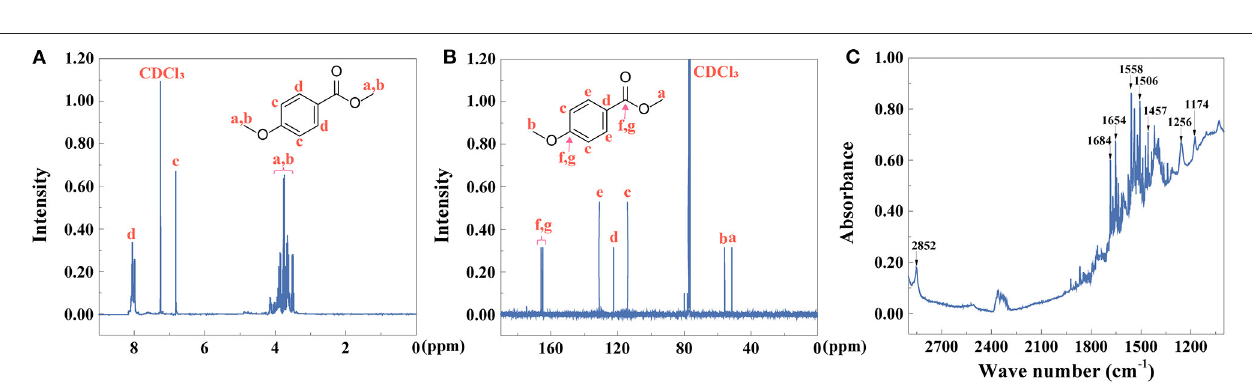
( Figure 4C ), O-H of carboxyl at 3,000–2,500 cm − 1 becomes weaker. The peaks at 3,100 3,000 cm − 1 or 1,680 1,620 cm −